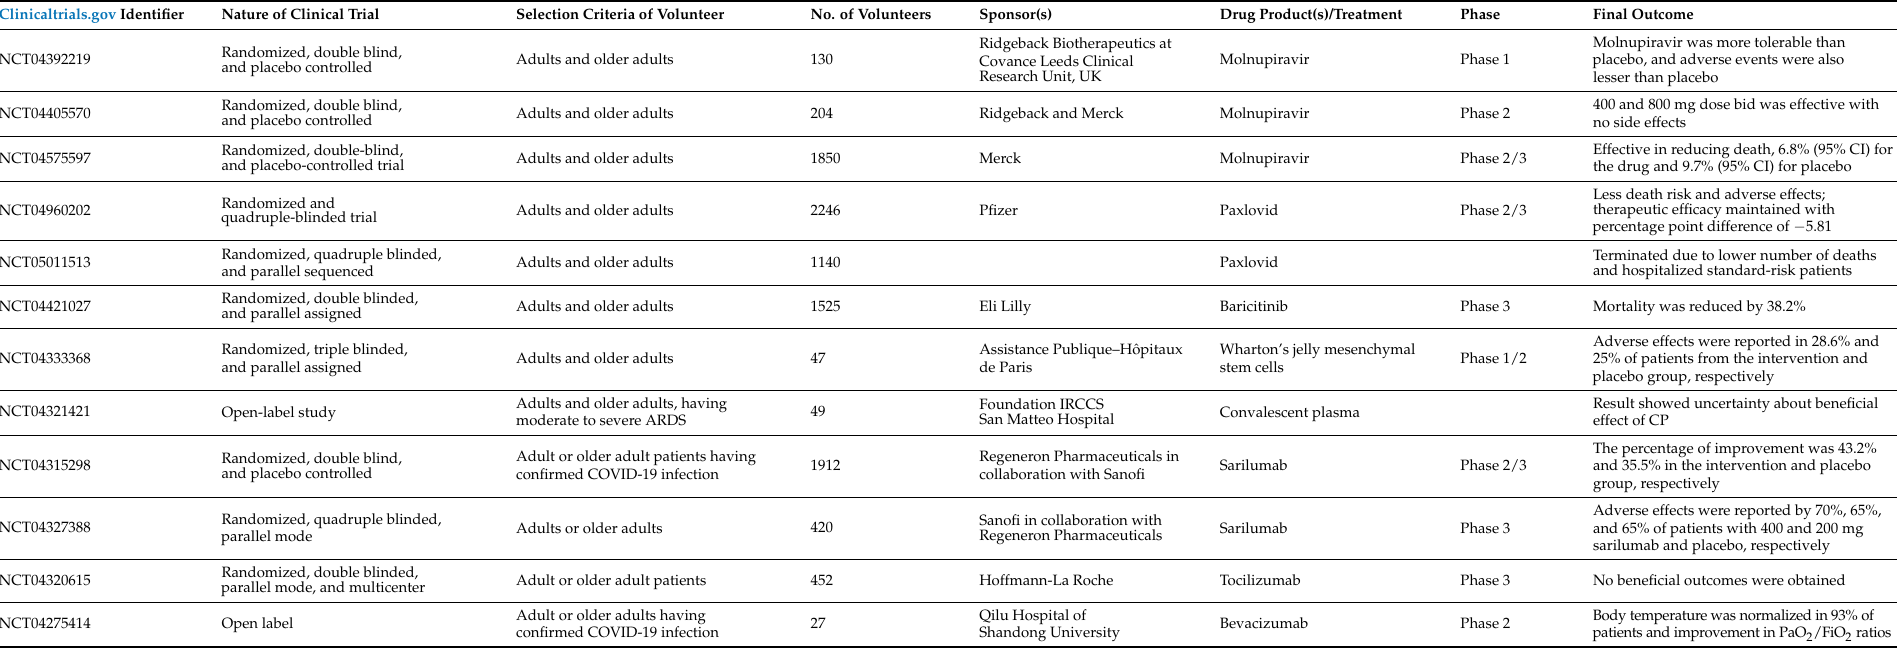
Table 1. Some clinical trials on new molecules and materials for the treatment of COVID-19 (source: clinicaltrials.gov; accessed on 24 January 2023).